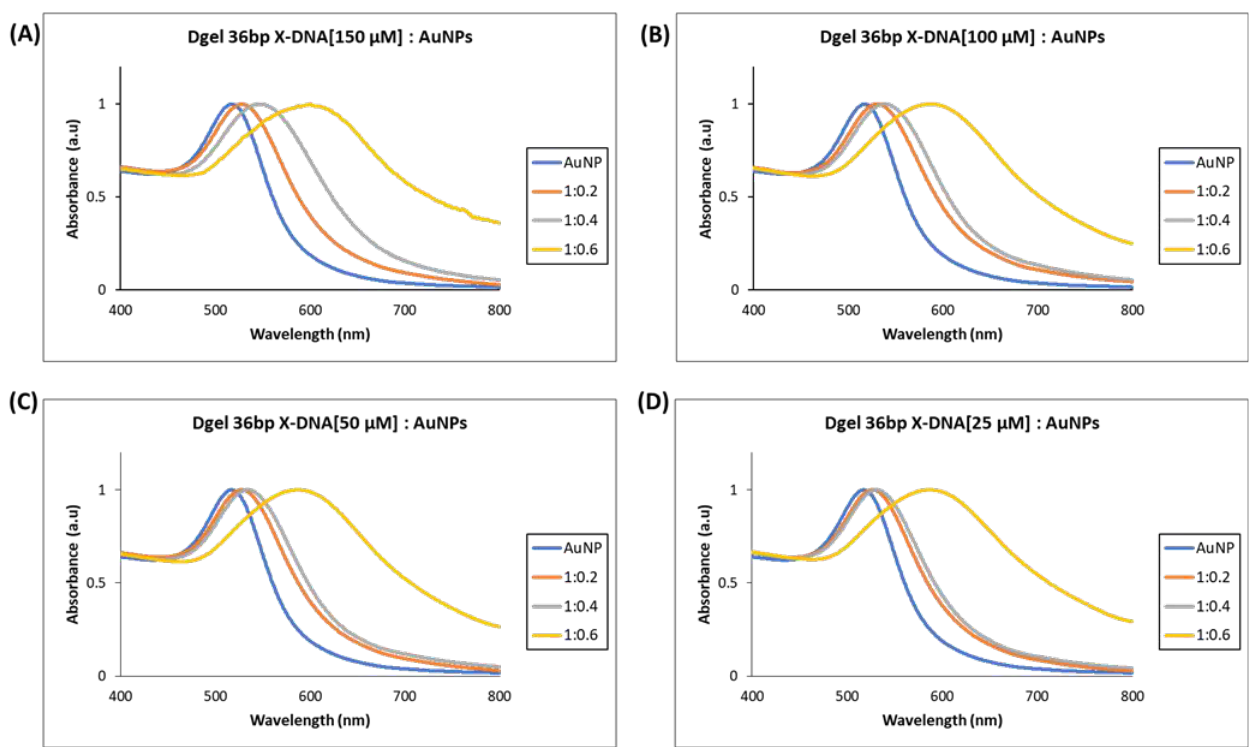
Figure 3. UV visible spectrum analysis of Dgel fabrication with the variations in the concentration of 36 bp X – DNAs, whereas AuNPs concentration and ratios, were constant, respectively. ( A ) Dgel (36 bp X – DNA [150 µM]: AuNPs) ( B ) Dgel (36 bp X – DNA [100 µM]: AuNPs) ( C ) Dgel (36 bp X – (36 bp X-DNA [150 µ M]:AuNPs) ( B ) Dgel (36 bp X-DNA [100 µ M]:AuNPs) ( C ) Dgel (36 bp X-DNA DNA [50 µM]: AuNPs) ( D ) Dgel (36 bp X – DNA [25 µM] AuNPs). [50 µ M]:AuNPs) ( D ) Dgel (36 bp X-DNA [25 µ M]